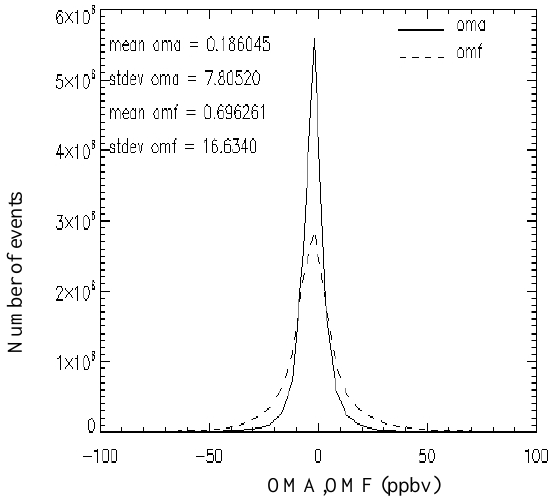
Fig. 9. Histograms of Observations Minus Analyses (OMA: solid lines) and Observations Minus Forecast (OMF: dashed lines) for the 7 MOPITT levels (surface, 850, 700, 500, 350, 250 and 150hPa) and from July 2004 to July 2005.